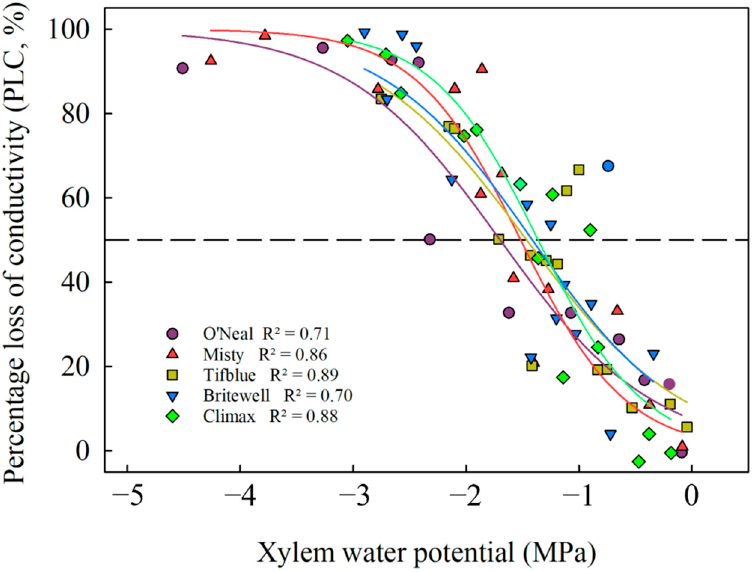
Figure 1. Xylem embolism vulnerability curves of five blueberry cultivar stems. The curves were established with the bench dehydration method. Different symbols and regression lines with the same color represent five blueberry cultivars. The horizontal dashed line gives 50% loss of hydraulic conductivity occurring in xylem.